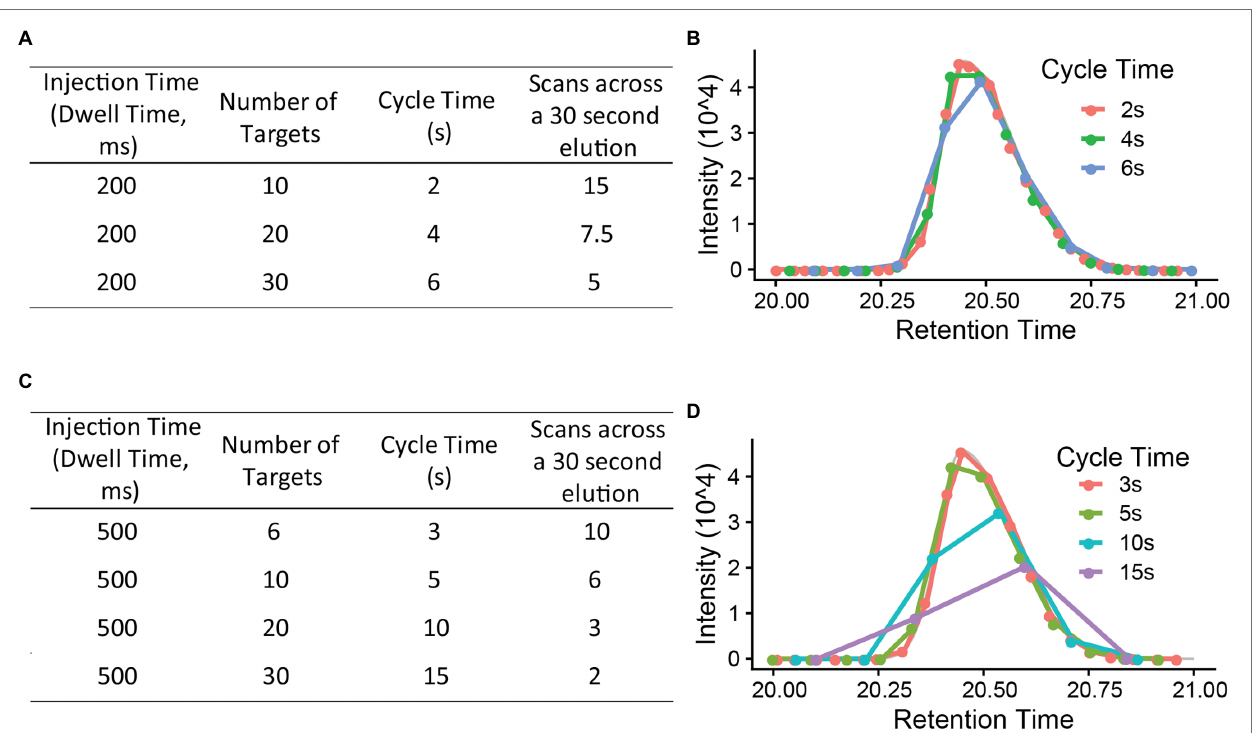
FIGURE 3 | The relationship between injection time, number of targets, cycle time, and scan number (points across a 30 s elution). (A,C) are using a 200 ms and 500 ms injection time each to calculate the cycle time and scan numbers (B,D) . x -axis is retention time (gradient, minutes). Injection time (the time to accumulate ions) is, in general, a rate limiting step in PRM method. A 8–10 scans across the chromatography peak are preferred to give a good quantification result.